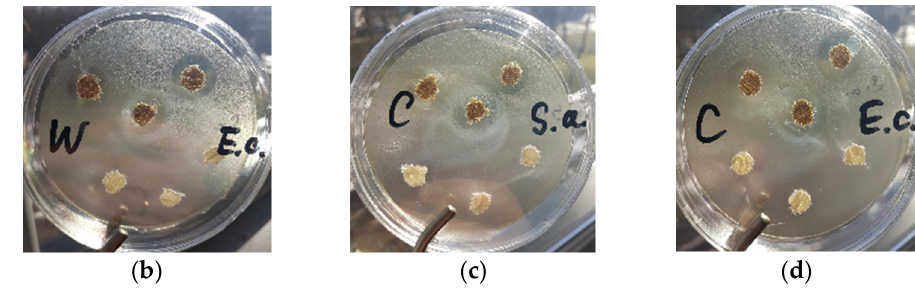
Figure 5. Photographs of untreated (bottom) and modified (top) samples of wool (W) and cotton (C) knitted fabrics against S. aureus ( a , c photos) and E. coli ( b , d photos) bacteria. The effect of the concentration of solutions on antibacterial properties was also studied.